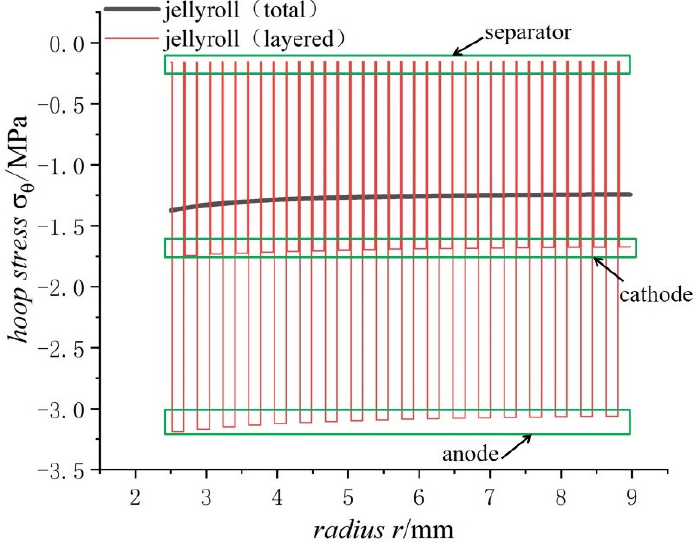
Figure 13. Comparison of the total and layered hoop stresses in the jellyroll of 18650 battery on a fully charged state.